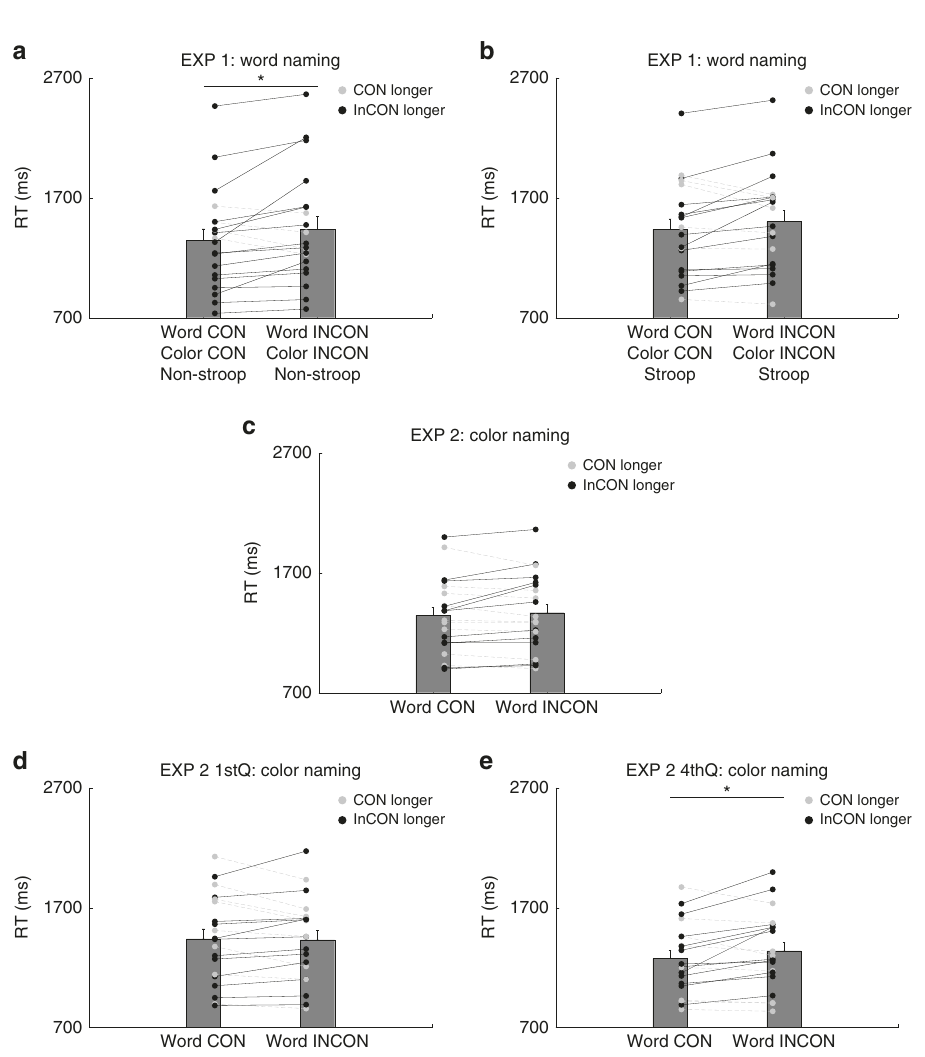
three-way interaction between target Stroop, word and color congruency, F (1, 19) = 5.81, p = 0.03, η p 2 = 0.23. Post hoc comparisons showed that double word-color incongruency sig- ni fi cantly slowed down target response only when the target was not a Stroop word (paired t(19) = − 2.43, p = 0.02, marginally